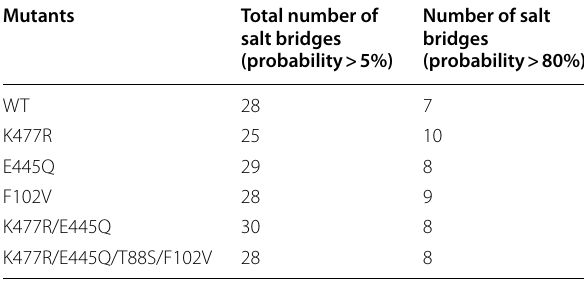
Table 3 Number of salt bridges in the wild-type CadA and its